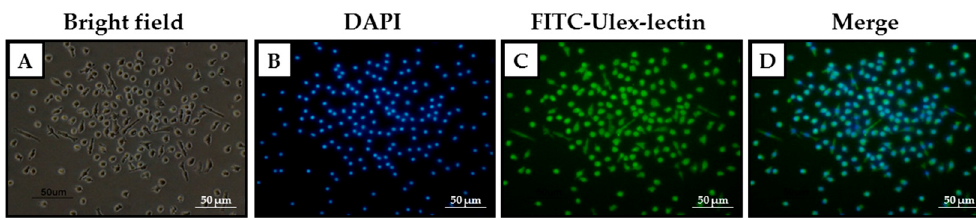
Table 1. Number of cells measured at days 7, 17, and 31 after seeding of EPCs by HD, MA, and ACVD subjects: Data were expressed as mean ± SD, and statistical significance was calculated through Student’s t -test by comparing MA and ACVD values to HD ones. EPC numbers, detected by counting four culture wells of at least three independent experiments, are shown.